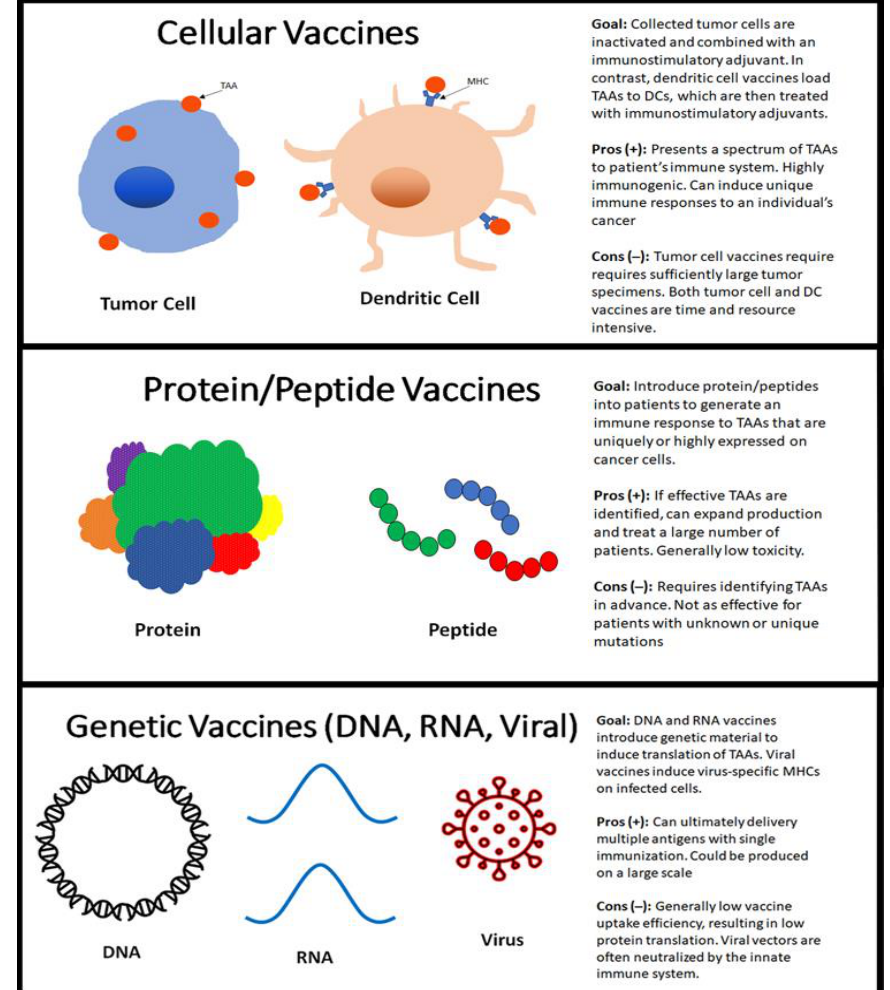
Figure 1. Mechanisms of vaccines: TAA, tumor associated antigens; DC, dendritic cell; DNA, deoxyribonucleic acid; RNA, ribonucleic acid; MHC, major histocompatibility complex.